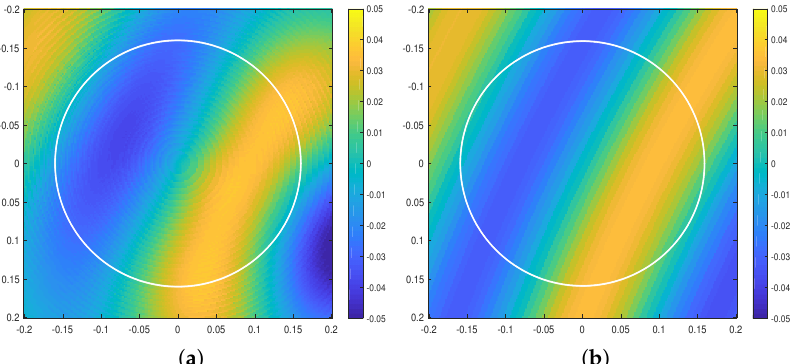
Figure 9. Comparison between ( a ) reconstructed sound field and ( b ) desired sound field at the horizontal plane with a height of z = 0.02 m.